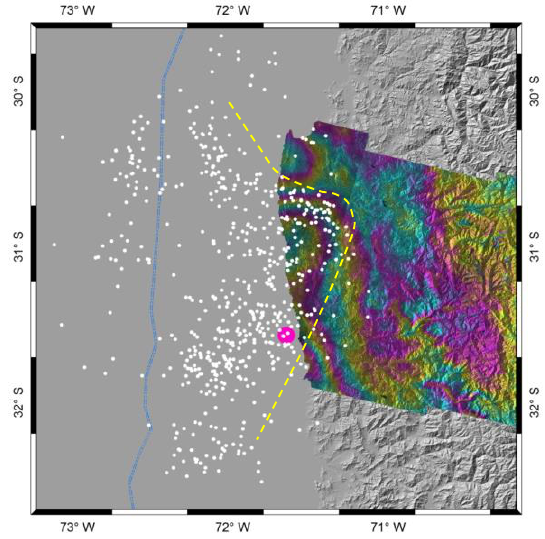
Figure 8. Map showing comparison between the aftershock distribution and the post-seismic deformation field. Pink point indicates Mw8.3 Mainshock, small white points mean aftershock (http://earthquake.usgs.gov, as of 11/10/2015),Blue dashed line shows the Chile trench,Yellow dashed line may be the projection of leading edge of the deductive plate tongue,a fringe stangards for 2.8cm displacement in LOS The observation results that the post-seismic deformation includes uplift and subsidence areas along the Chile coast is probably related with the existing traverse fault that coordinates plate motion. This fault may expose on the surface, or hides beneath the ground (where there is a major river as seen on Google Earth). The presence of this traverse fault can result in different locking and slip characteristics along the subduction zone. South to this fault, the motion of the oceanic crust after the earthquake dominates the subducting slab, while the displacement opposite to the coseismic in the continent due to drag from the underlying oceanic plate. While north of this